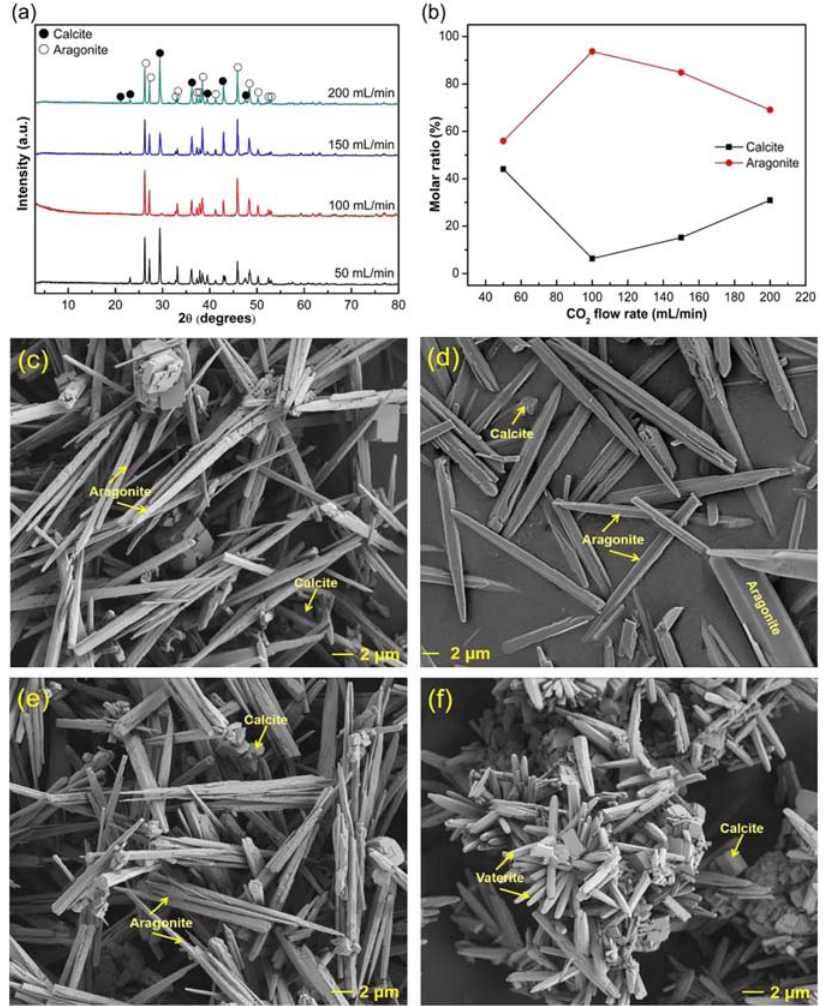
Figure 5: E ff ect of CO 2 fl ow rate on crystal phase and morphology: ( a ) XRD patterns of the product, ( b ) composition of the products calcite and aragonite, and SEM images of the carbonation product at ( c ) 50 mL / min, ( d ) 100 mL / min, ( e ) 150 mL / min, and ( f ) 200 mL /